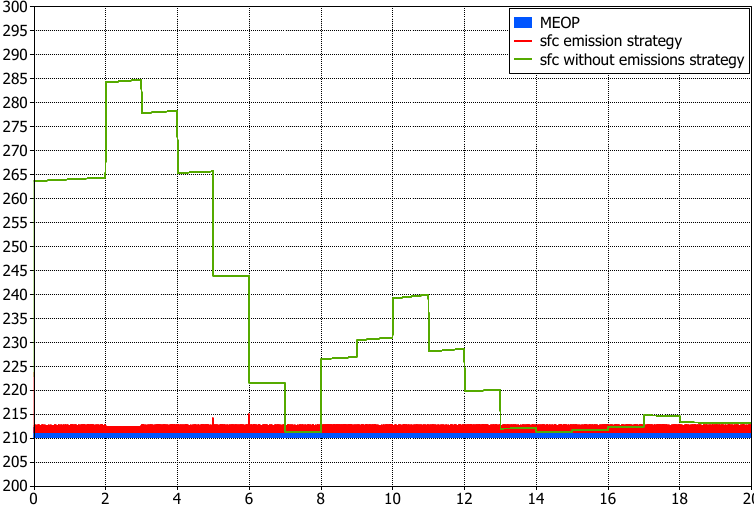
Figure 13. Instantaneous sfc with and without the optimization strategy.